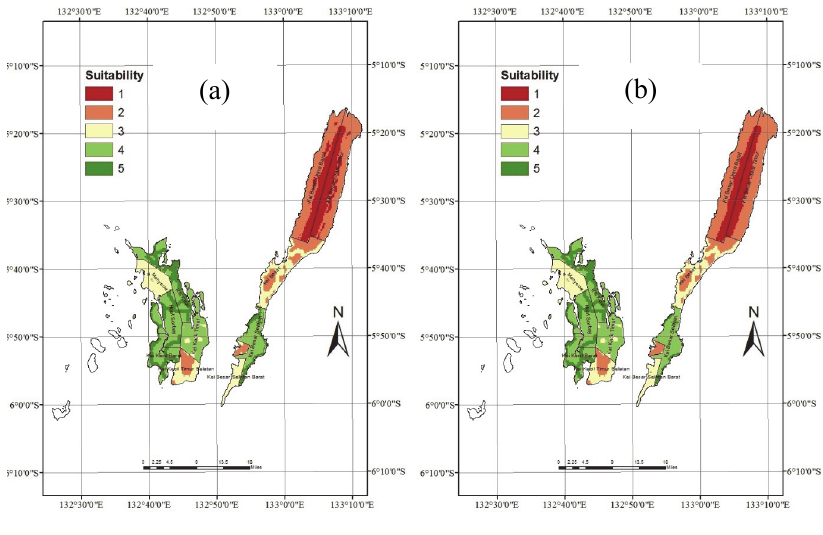
Fig. 6. Suitability with no restriction: (a) Fuzzy AHP; (b)